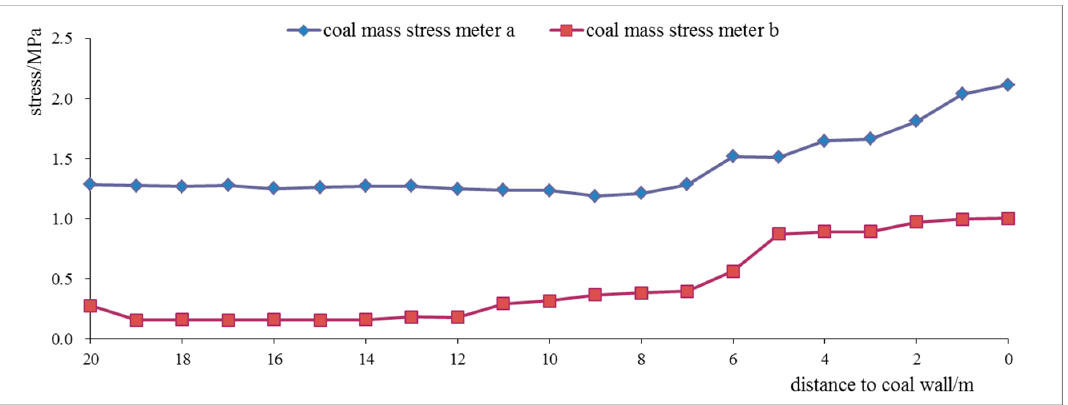
Figure 11. Variations of coal stress in the meters.